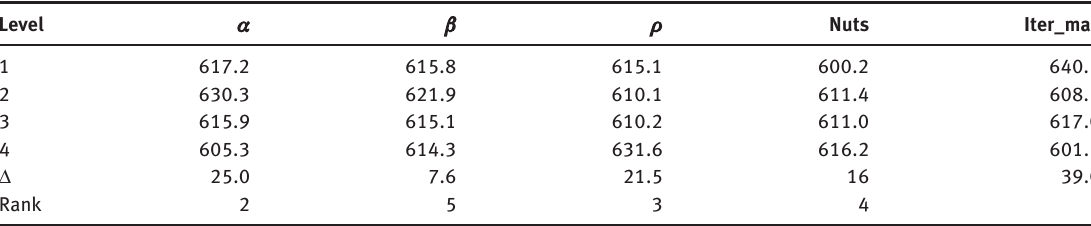
Table 5: Analysis of